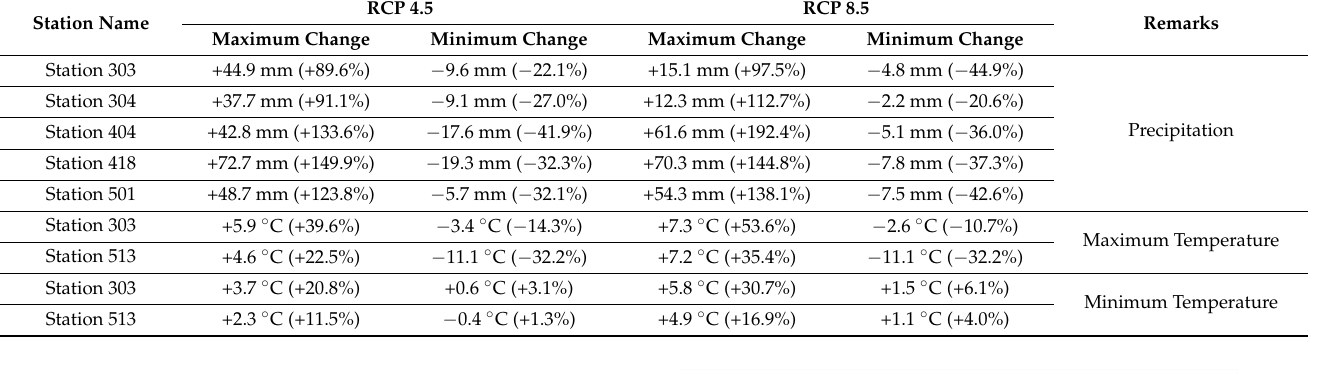
Table 3. The maximum and minimum shift in precipitation and temperature projection values at various stations under different climatic scenarios in the Thuli Bheri River Basin. The ‘+’ sign indicates the overestimation, and the ‘ − ‘ sign indicates the underestimation. The values within parentheses represent the respective values in percentage (%).